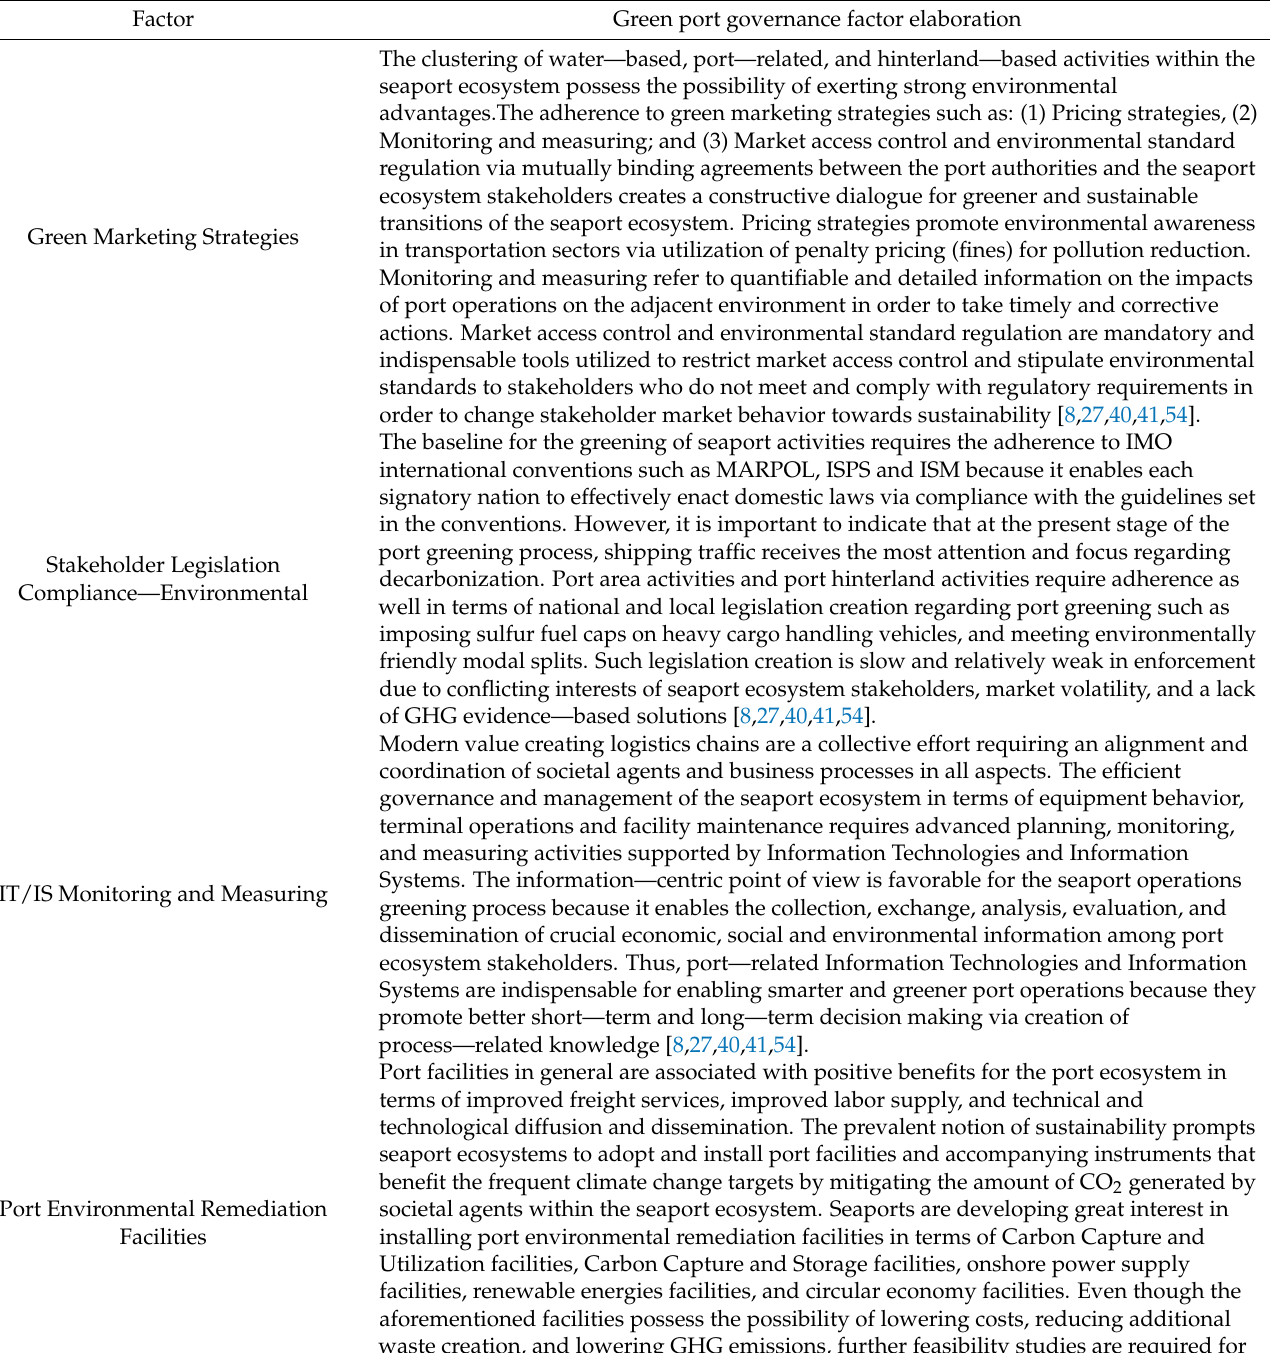
Table 7. Cont. Factors Belonging to the Responses Category Green port governance factor